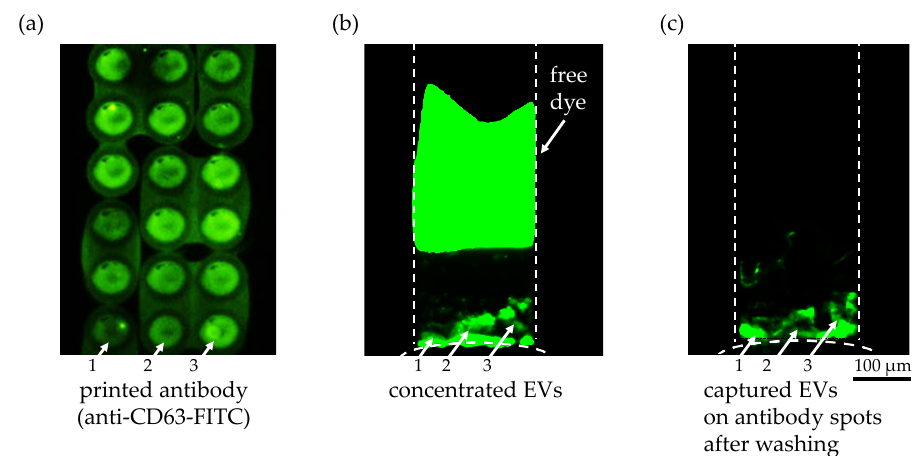
Figure 5. Anti-CD63 antibody on a Super Epoxy 3 slide to capture extracellular vesicles. ( a ) Printed anti-CD63 FITC-labeled antibody after two washing steps to validate the washing protocol. The difference in antibody density within a single spot as well as between spots was clearly visible as indicated with white arrows 1, 2, and 3. ( b ) Fluorescent image of the preconcentrated EVs in the microchannel from an initial concentration of 9.3 × 10 7 particles/1 mL during ICP for 21 min at 45 V/cm (ND 1 filter and 1 s exposure time). The fluorescently labeled EVs bound on the circular spots of the printed anti CD-63 antibody solution are indicated with white arrows 1, 2 and 3. A second fluorescent plug was visible in the upper region of the microchannel representing the unbound free dye that was separated from the EVs during ICP due to its higher electrophoretic mobility. ( c ) After turning off the voltage at 30 min, the pressure-driven flow from the buffer solution washed away any unbound EVs and free dye into the sample reservoir. The fluorescently labeled EVs bound on the circular spots of the printed anti CD-63 antibody are highlighted with white arrows 1, 2, and 3. The difference in the amount of bound EVs on the antibody spots can be explained by the variation of the antibody density in the spots, as shown in ( a